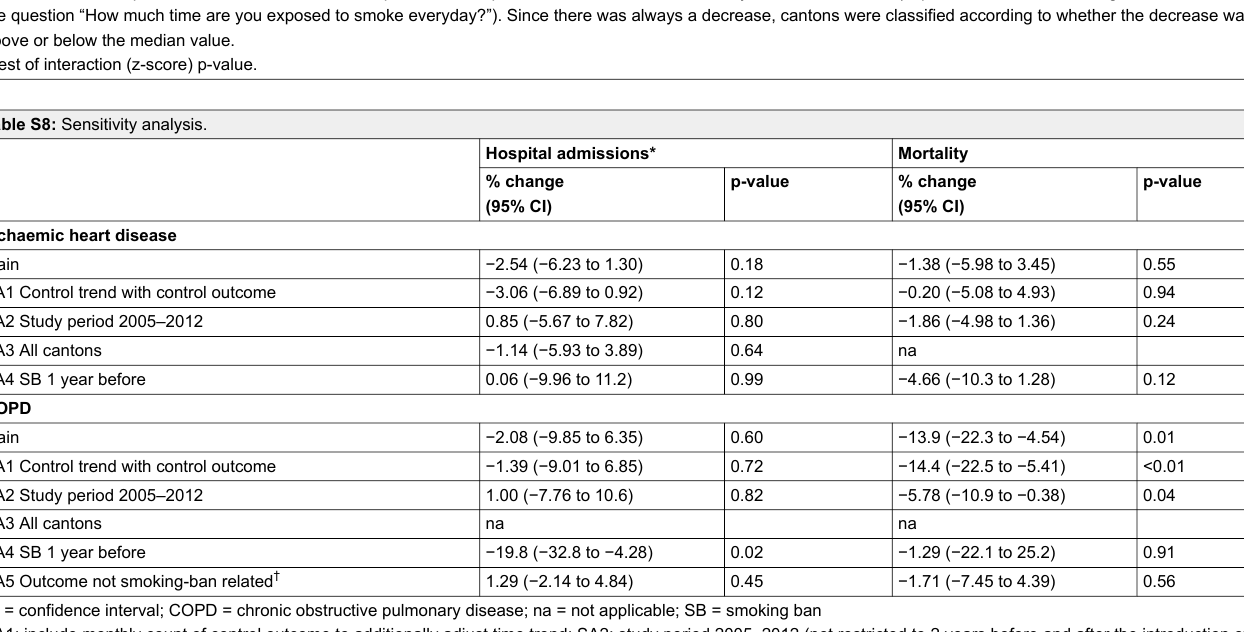
Table S8: Sensitivity